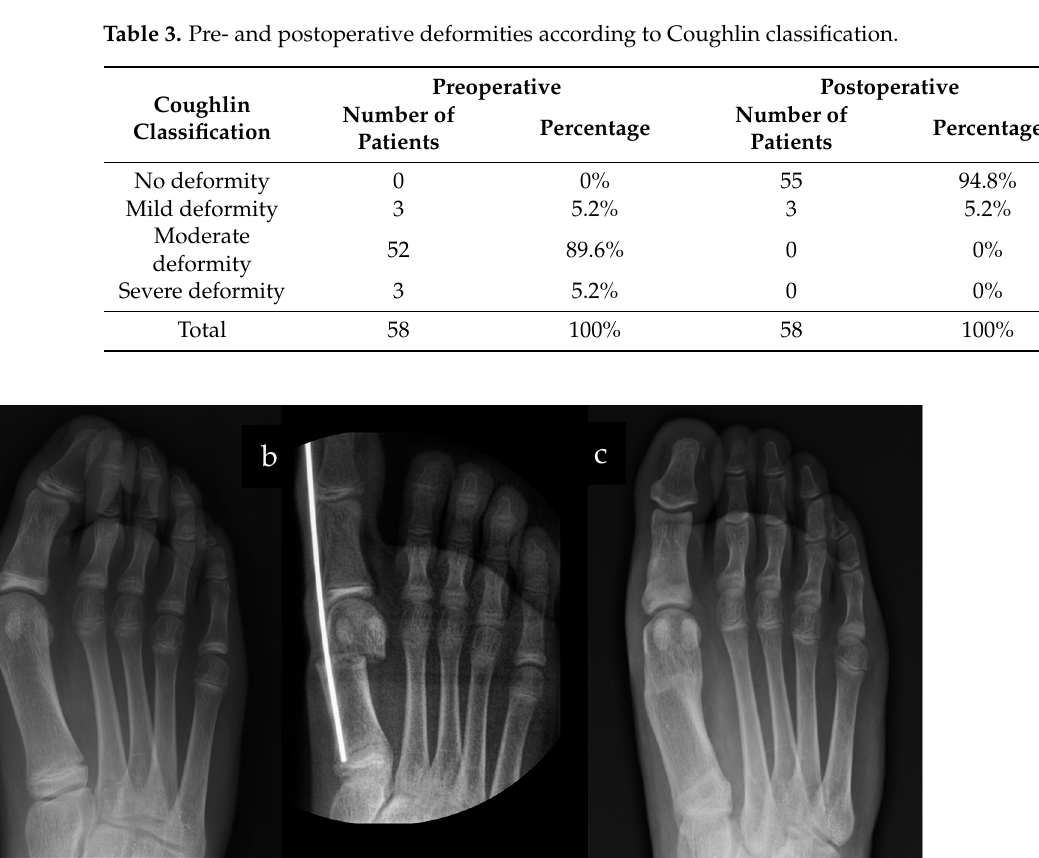
Figure 3. ( a ) Preoperative, ( b ) Intraoperative and ( c ) 12 months postoperative